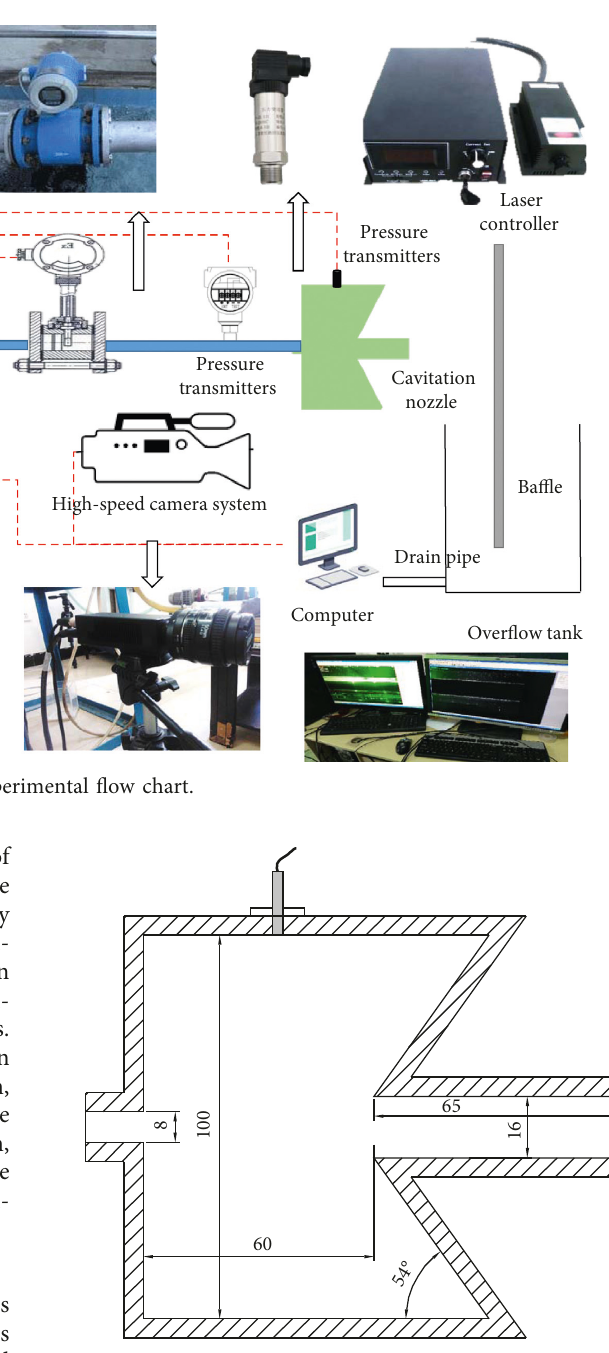
Figure 2: Diagram for experimental